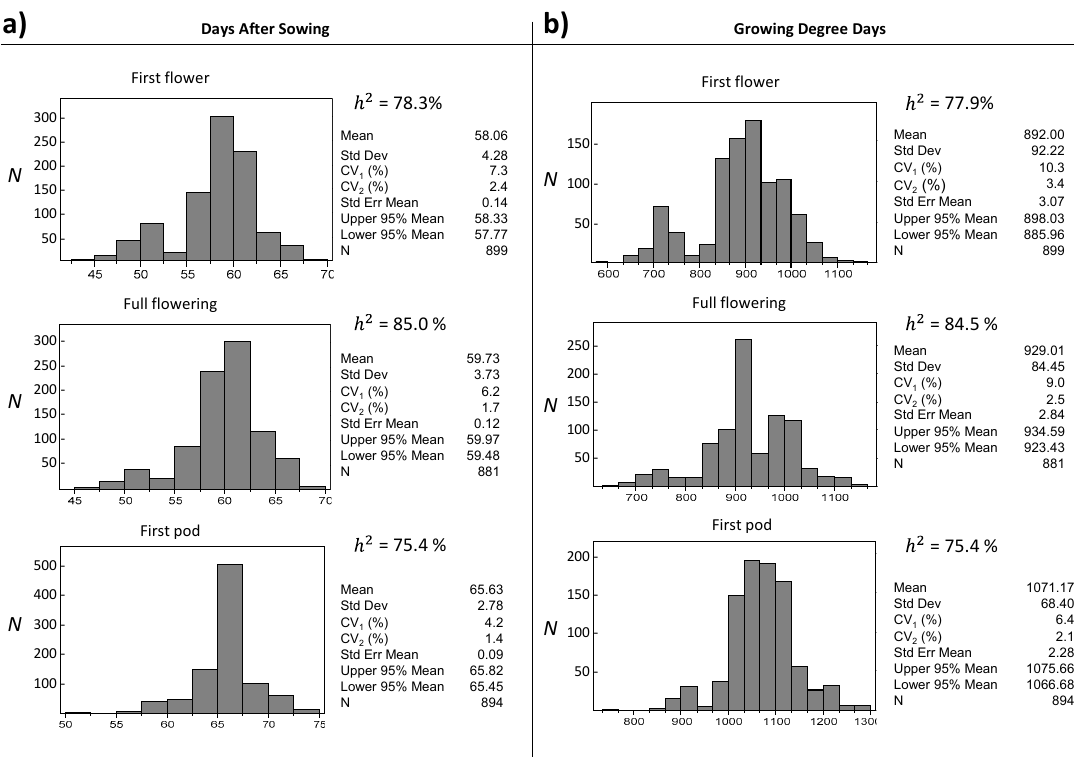
Figure 3. Frequency distributions and heritabilities of the flowering traits across the UNIVPM_Ca_core2 panel, measured as days after sowing ( a ) and as growing degree days ( b ); N , number of accessions; CV 1 , coefficient of variation based on the population mean; CV 2 , coefficient of variation between biological replicates.